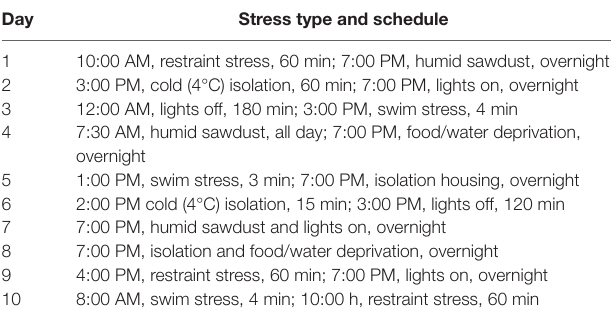
TABLE 1 | Protocol of CVS. Day Stress type and